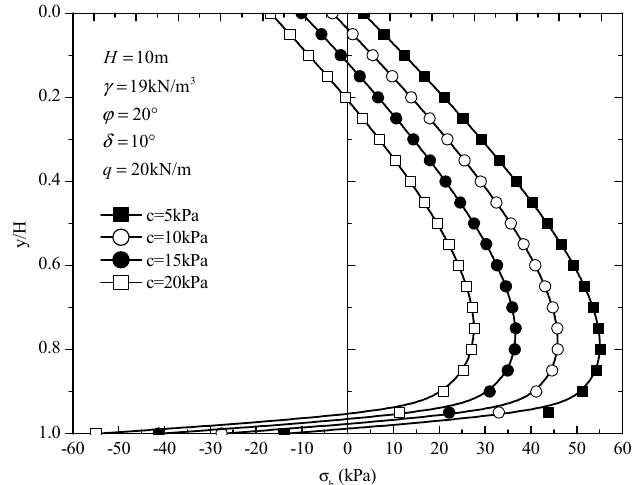
Figure 5. Variation of active earth pressure distribution with the cohesion of backfill soil ([Rao et al. 2015], with permission from ASCE).